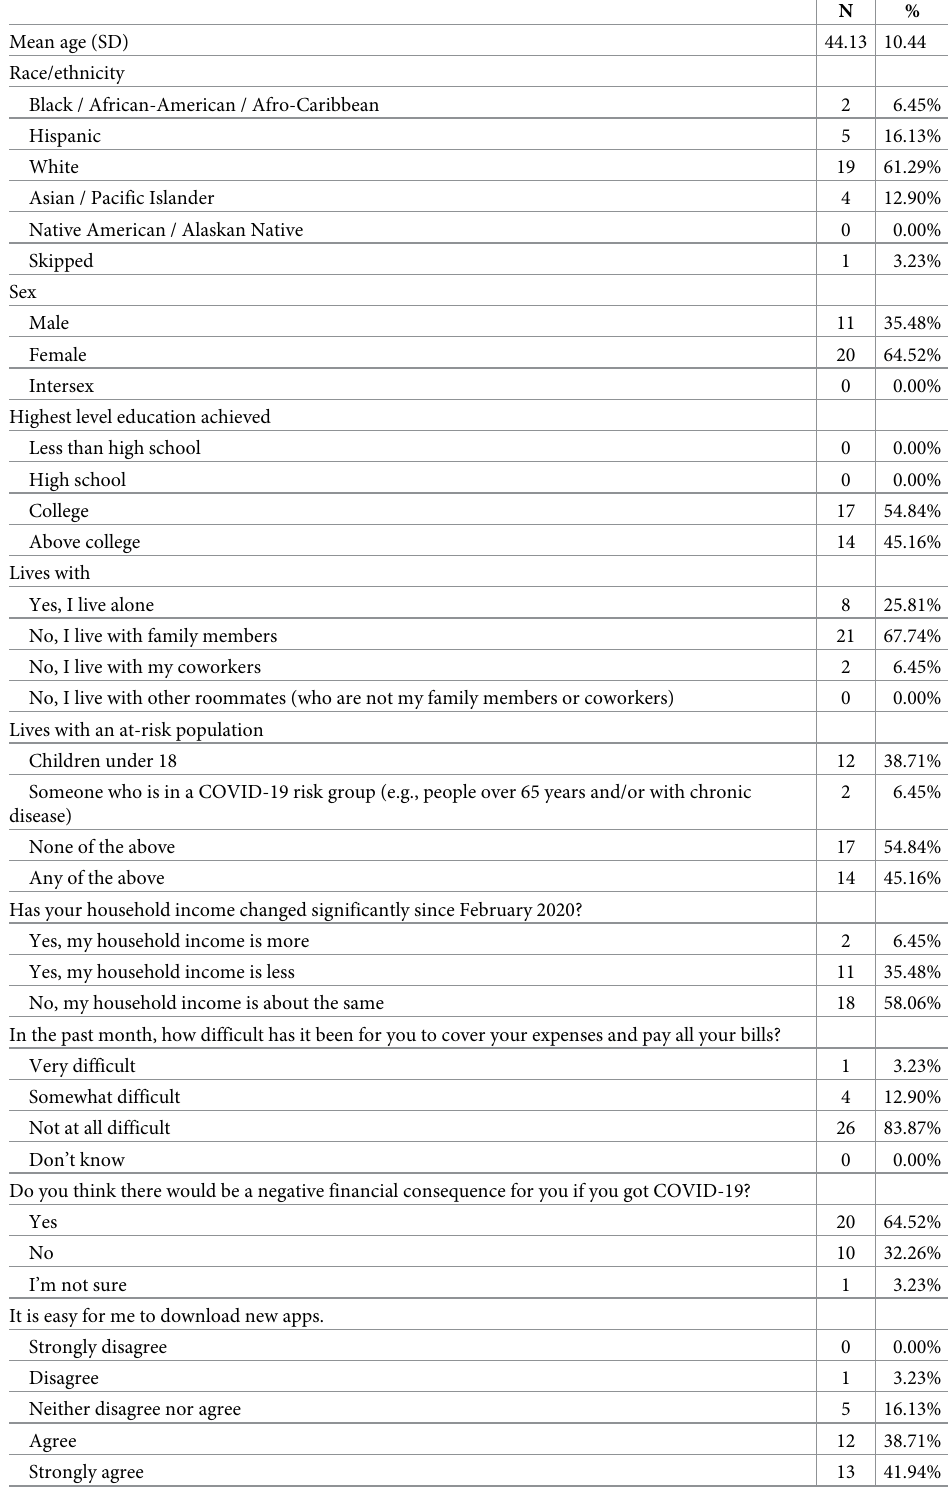
Table 1. Study participant demographics at enrollment (N =